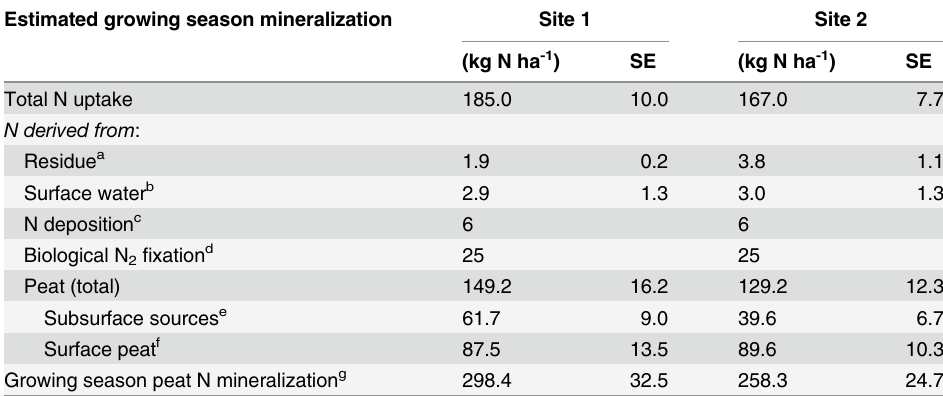
Table 4. Estimated growing season mineralization based on plant uptake. Estimated growing season